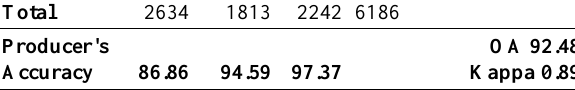
Table 4. Error matrix for accuracy assessment at Image Resolution 0.03 m.